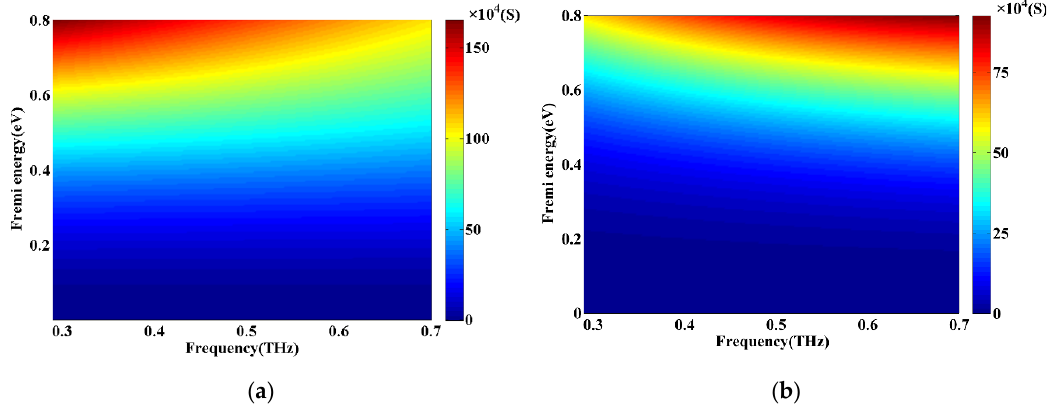
Figure 2. The frequency dependent graphene surface conductivity with different Fermi energies: ( a ) real and ( b ) imaginary parts.